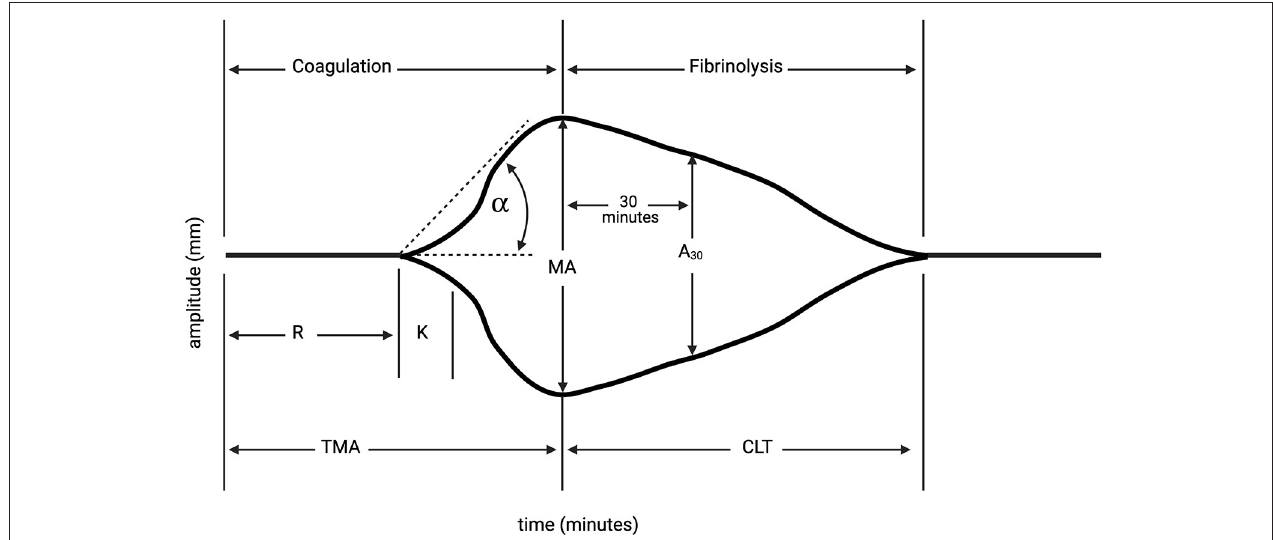
FIGURE 2 | Thromboelastography (TEG). TEG is a hemostatic blood test which dynamically evaluates platelet function and clotting efficacy of whole blood. Reaction time (R) is latency from start of test to initial fibrin formation, and is dependent on clotting factors (normal: 4–8min). Kinetics (K) is the duration taken to achieve clot strength of amplitude 20 millimeters (mm) (normal: 1–4min). Alpha ( α ) measures the speed of fibrin cross-linking, dependent on fibrinogen (normal: 47–74 ◦ ). Maximum amplitude measures ultimate strength and stability of fibrin clot (mm) (normal: 55–73mm). Time to reach maximum amplitude (TMA); percentage decrease in amplitude 30-min post-MA (A 30 ); Clot lysis time (CLT). At our institution, hypocoagulability on TEG is defined as a prolonged reaction time (R-time, minutes to clot formation), low alpha angle (measures clot kinetics), and low maximum amplitude (MA, millimeters, measures clot strength). Created with Biorender.com.